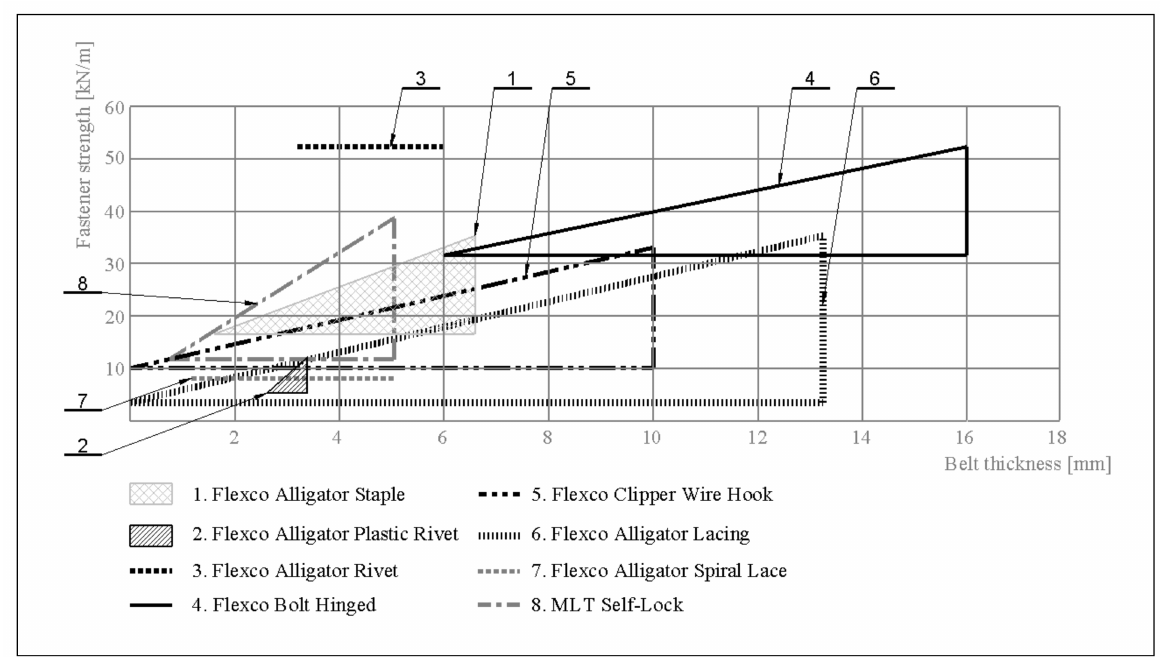
Figure 26. Design map for the selection of a mechanical connection in the range of conveyor belt thickness from 0 to approximately 18 mm and in the range of fastener strength from 0 to approximately 60 kN/m.